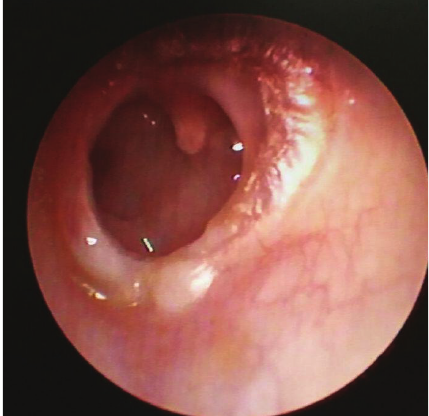
Figure 1: Foreshortened manubrium seen on otoendoscopy.